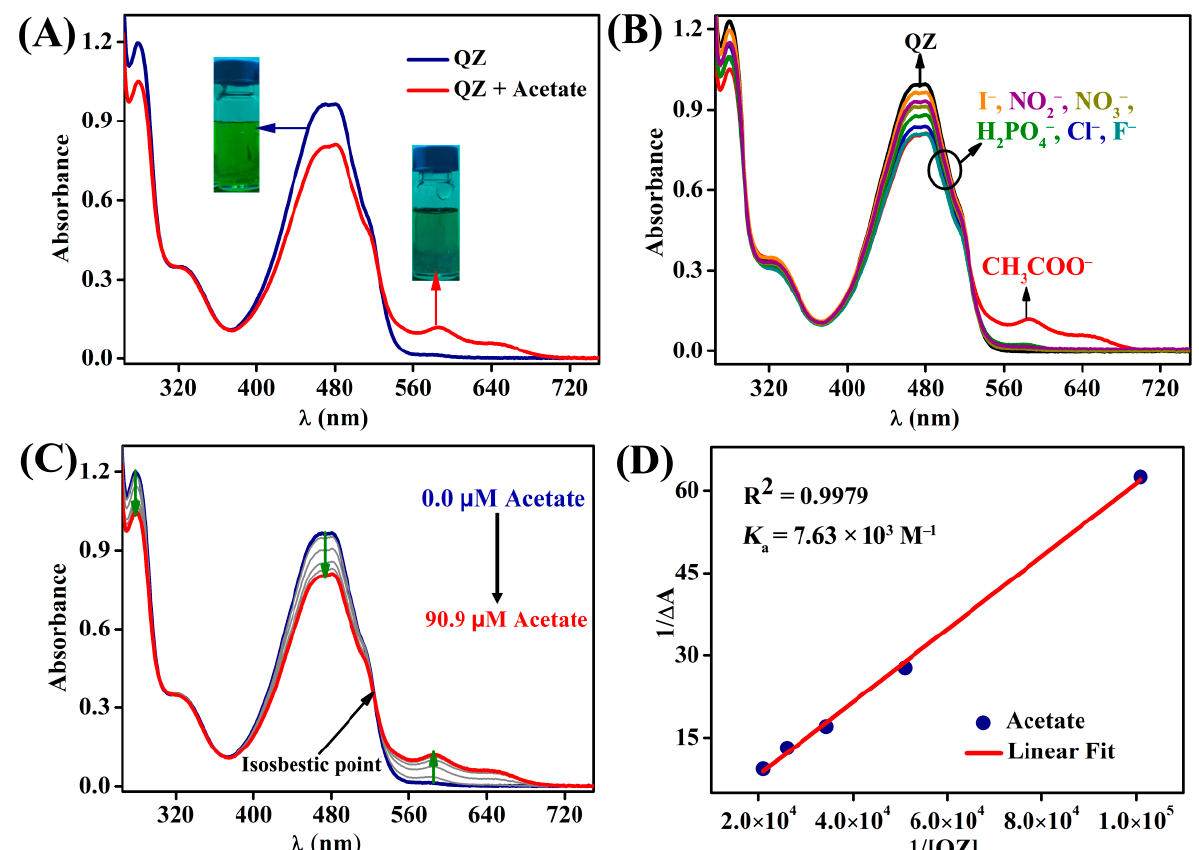
Figure 2. ( A ) The UV–visible absorption spectrum of QZ before and after the addition of 10 equiv. of CH 3 COO - anions (Inset: corresponding visual color changes). ( B ) The observed changes in absorption intensity of QZ after the addition of 10 equiv. of different anions. ( C ) Relative changes in UV–visible absorption intensity after increasing CH 3 COO - anion concentrations. ( D ) Corresponding Benesi–Hildebrand plot.